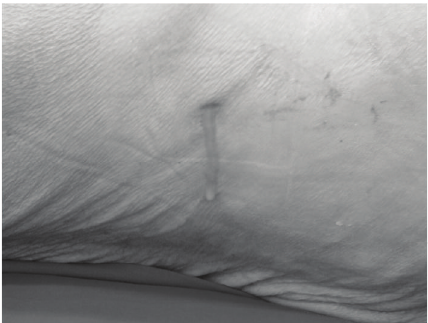
Figure 1: A purulent cutaneous fistula appeared in the lumbar area.